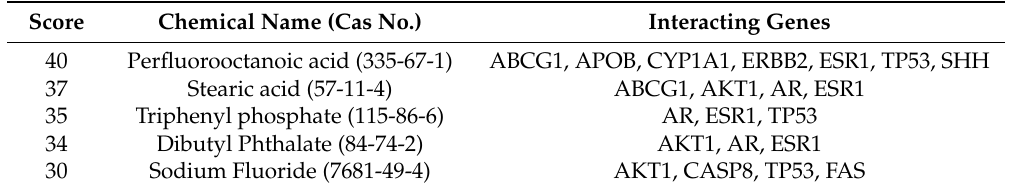
Table 3. The list of top five candidate EDCs with the score and their interacting genes curated from CTD. Score Chemical Name (Cas No.)